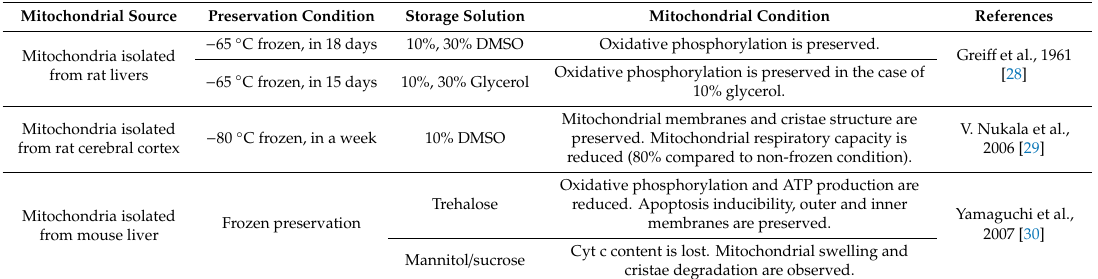
Table 5. Summary of the cryopreservation of